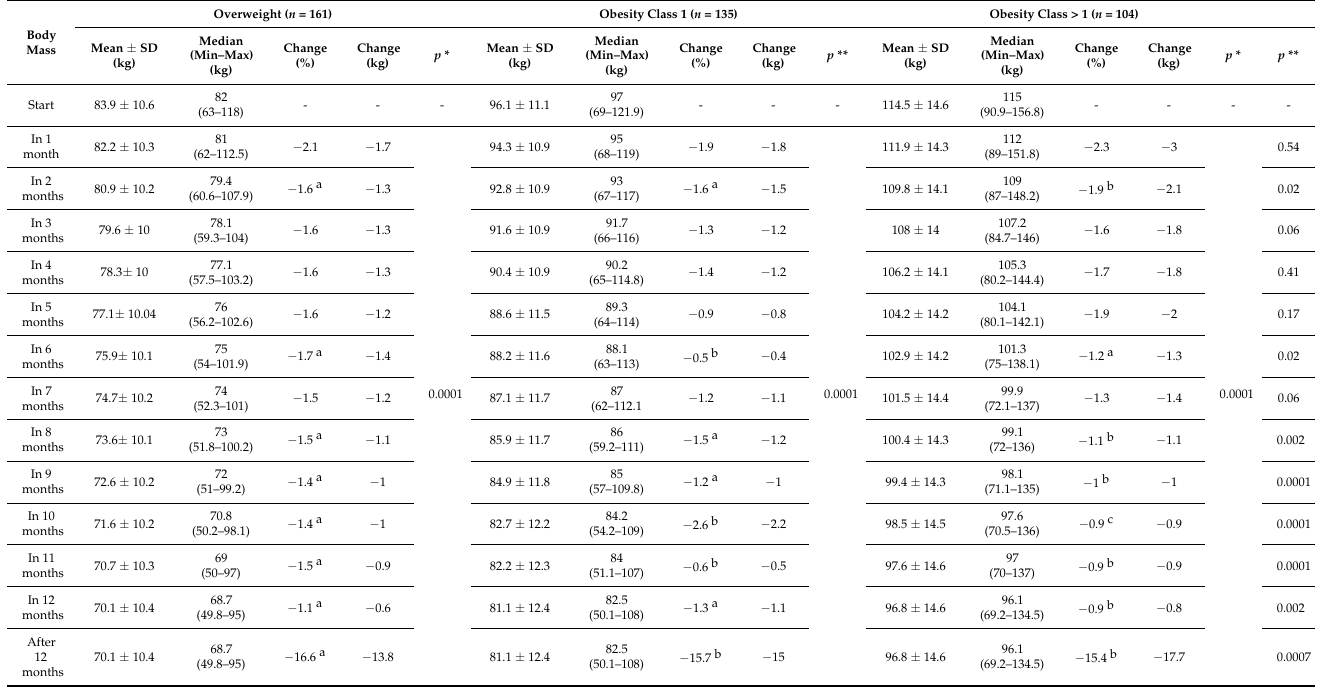
Table 4. Changes in body weight in BMI groups over 12